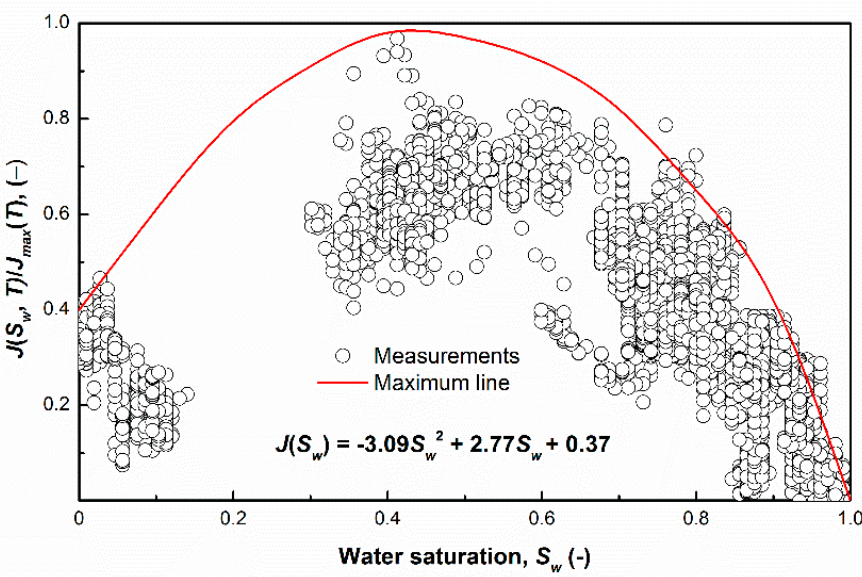
Figure 13. Correlation between CO 2 flux from soil ( J ) and water saturation ( S w ), recorded at Location A (Jul 31, 2017 to Oct 9, 2017).